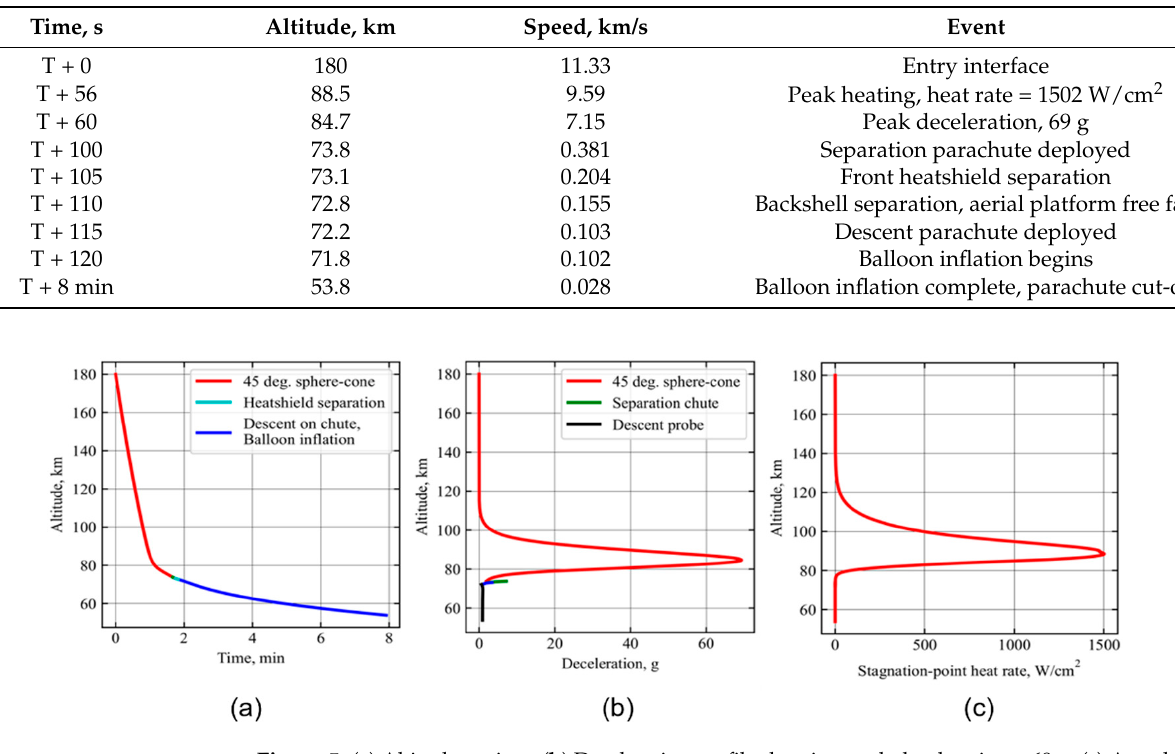
Figure 5. ( a ) Altitude vs time. ( b ) Deceleration profile showing peak deceleration = 69 g. ( c ) Aerodynamic heating profile showing peak heat rate = 1502 W/cm 2 . The deceleration load and heat rates can be reduced with a shallower entry and lower ballistic coefficient of entry vehicle.